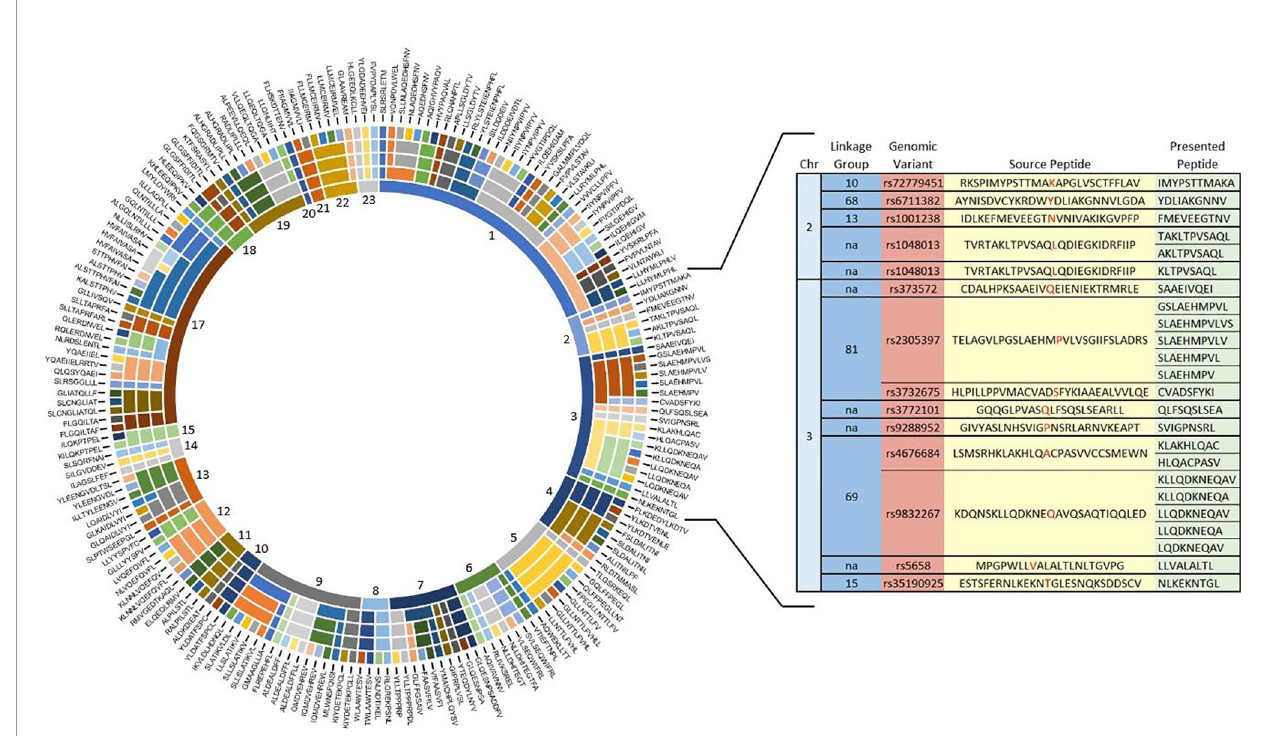
FIGURE 3 | Outcomes associated with recipientmismatchingfor individual genomicvariant discoveries may be explainedby linkage with other variants collectively encodingsets ofsource peptides predictedto produce multiple processed peptides that bind HLA-A*02:01. From the innermost ringto the outermost ring, thedoughnut chart shows numberedchromosomallocations, linkage groups, variant discoveries, source peptides and processed peptides predictedto bind HLA-A-*02:01. None ofthe discoveries was mapped to chromosome 16. See Table S4 for source data. Details of discoveries in chromosomes (Chr) 2 and 3 show arbitrarily numberedlinkage groups (dark blue column) of genomicvariants (brown column) encodingsource peptides (yellow column) predicted by NetMHCpan4.1 to produce processedpeptides that bind HLA-A*02:01 (green column).Variant amino acids inthe source peptides are identi fi ed in red font. Variants not included in a linkagegroupare designated “ na. ”